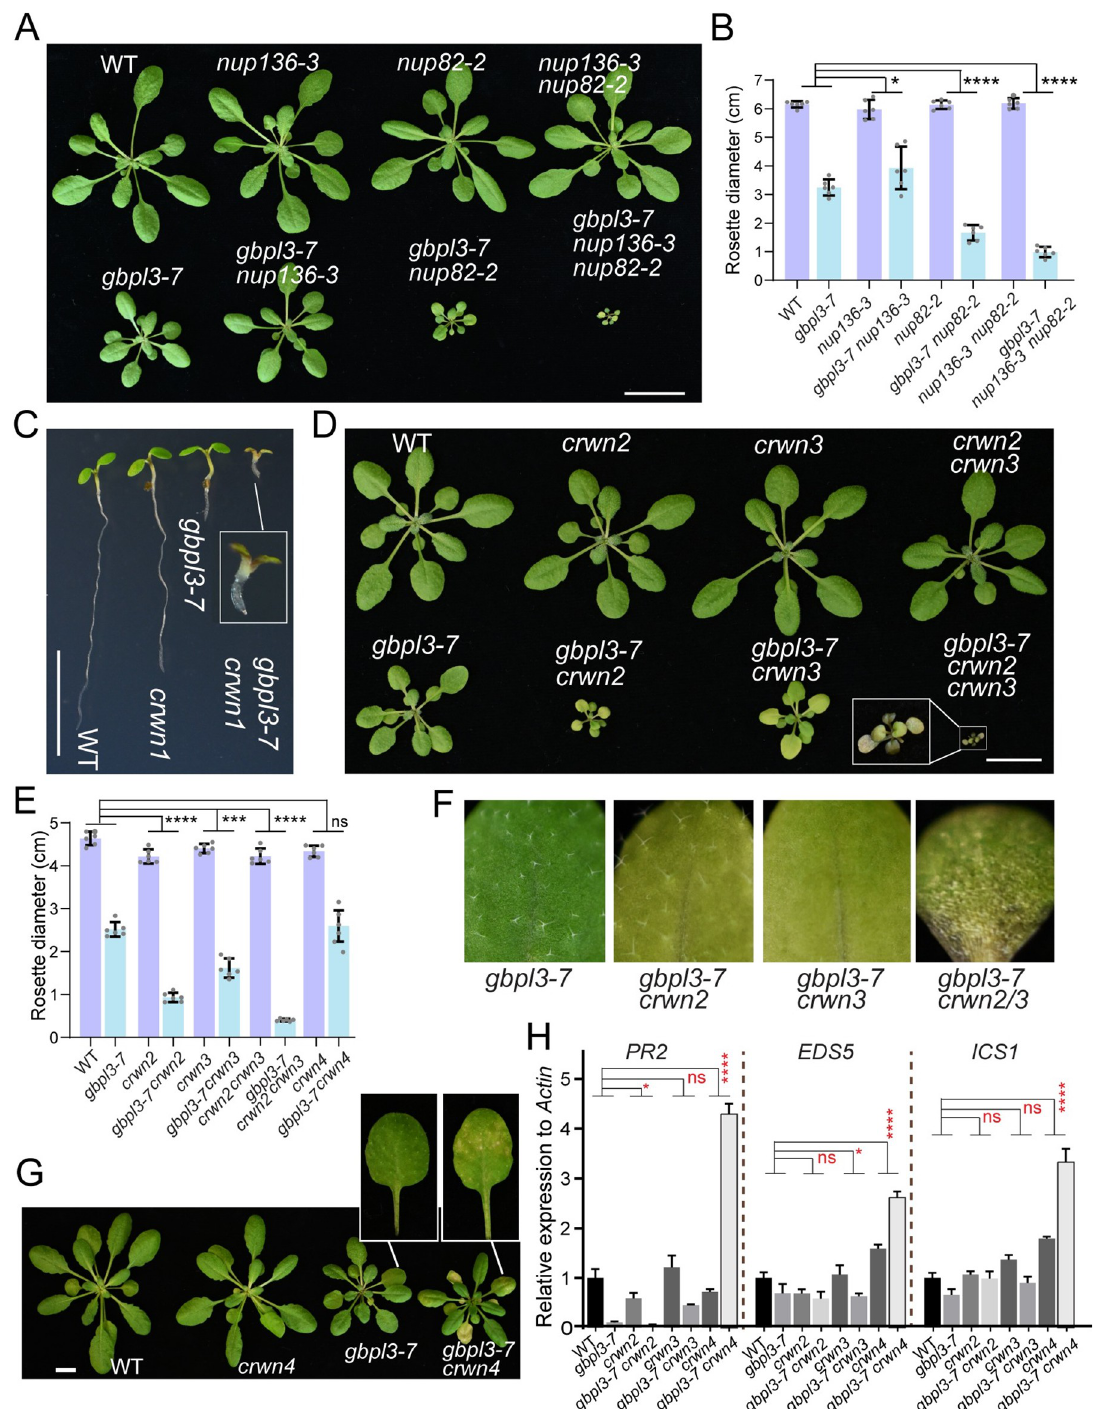
Fig 5. GBPL3 functions with nuclear basket and nucleoskeleton components to differentially regulate plant development and stress responses. (A) Four-week-old plants of WT, nup136-3 , nup82-2 , nup136-3 nup82-2 (upper panel) and gbpl3-7 , gbpl3-7 nup136-3 , gbpl3-7 nup82-2 , and gbpl3-7 nup136-3 nup82-2 (lower panel) are shown. (B) Statistics of rosette diameter from 4-week-old plants. Bars represent means ± SD ( n = 8 biological replicates). Similar results have been obtained 3 times. (C) Genetic interaction between gbpl3-7 and crwn1 mutant. Five-day-old seedlings are shown. (D) Genetic interaction between gbpl3-7 and crwn2 / crwn3 . Four-week-old plants are shown. (E) Statistics of rosette diameter from 4-week-old plants. Bars represent means ± SD ( n = 8 biological replicates). (F) Images and statistics of trichomes on the third rosette leaves of 4-week-old plants. (G) Four-week-old WT, crwn4 , gbpl3-7 , and gbpl3-7 crwn4